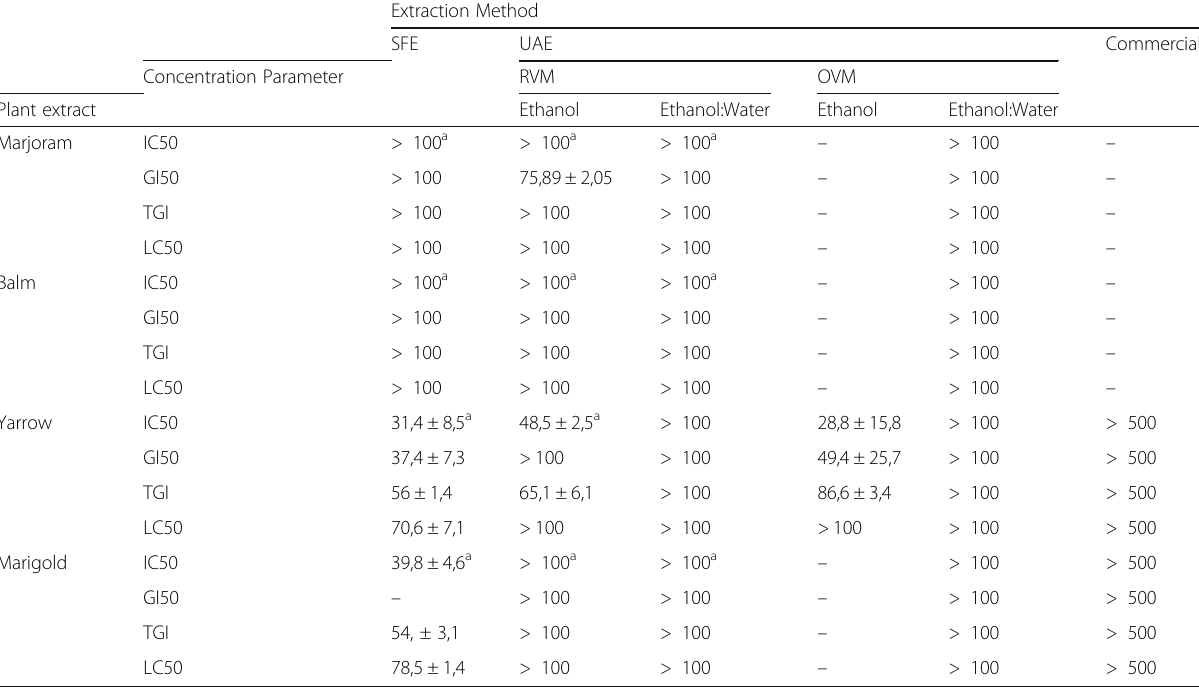
Table 1 Concentration parameters of the selected plant extracts on MIA PaCa-2 cell line sensitivity depending on the extraction